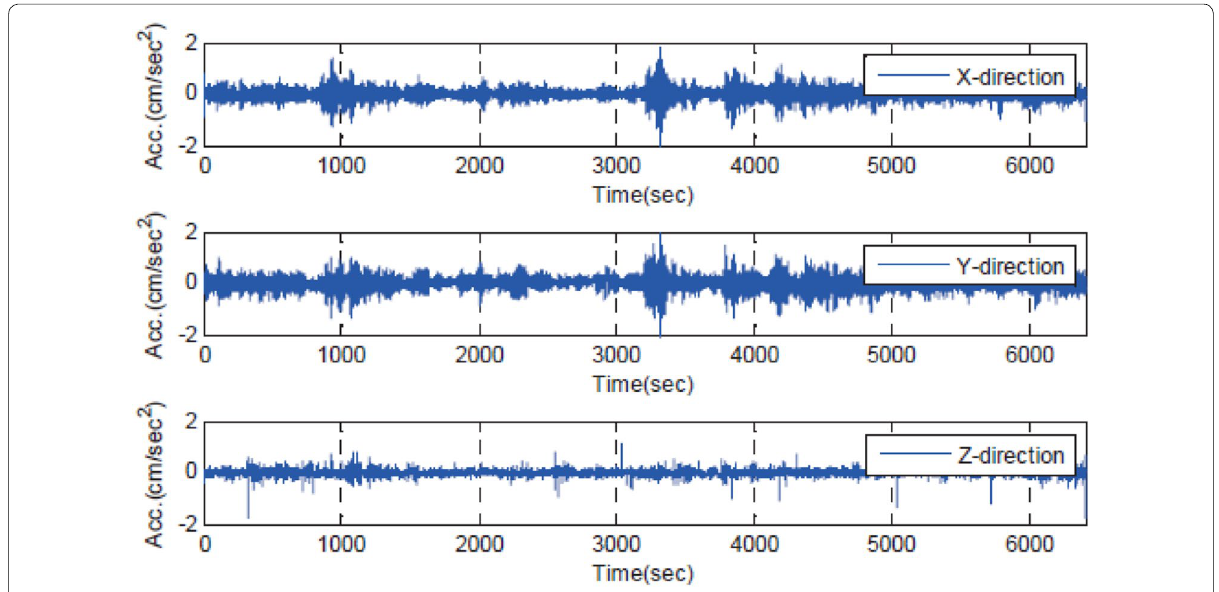
Fig. 11 Accelerograms at